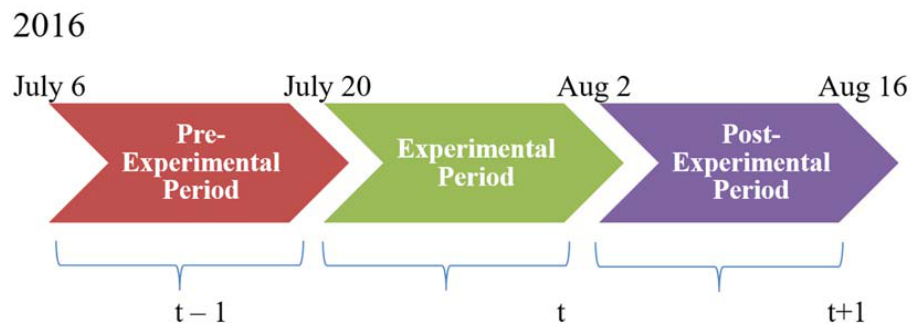
Figure 5. Experimental procedure.